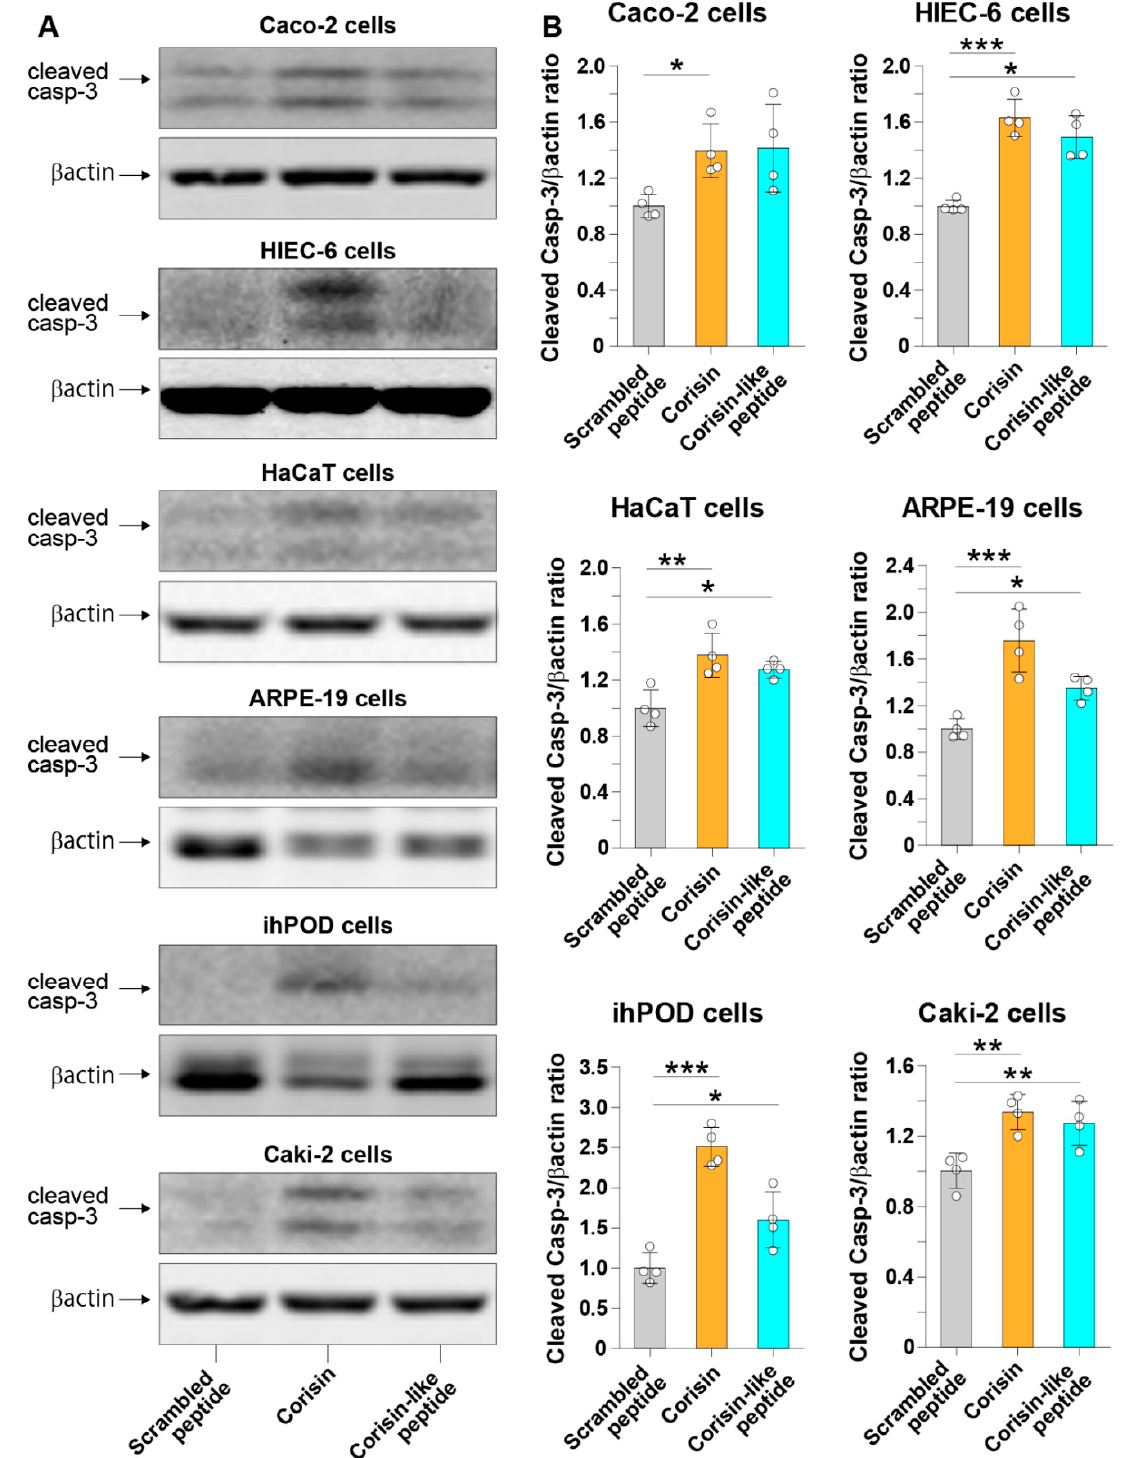
Figure 4. Cleavage of caspase-3 in cells treated with corisin or corisin-like peptide. Colon (Caco-2) epithelial cells, small intestinal (HIEC-6) cells, keratinocytes (HaCaT cells), retinal (ARPE-19) cells, podocytes (ihPOD), and renal tubular epithelial (Caki-2) cells were cultured in the presence of corisin or corisin-like peptide for 24 h, and apoptosis was evaluated by Western blotting ( A ). Densitometry analysis was performed using ImageJ ( B ). Data are expressed as the mean ± S.D. Statistical analysis by ANOVA with Newman-Keuls’ test. * p < 0.05, ** p < 0.01, *** p < 0.001.